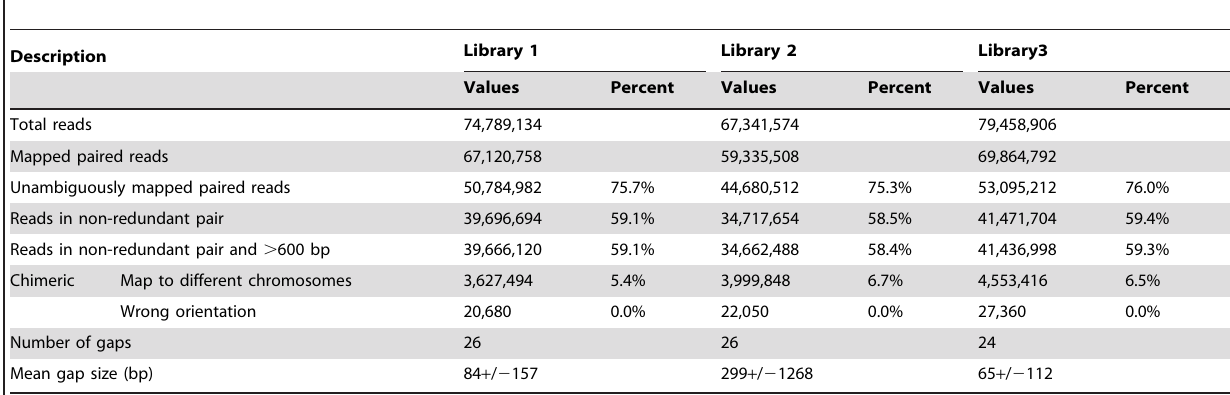
Table 2. Results from the alignment of Saccharomyces cerevisiae Illumina 12 kb CLIP-PE libraries to the reference